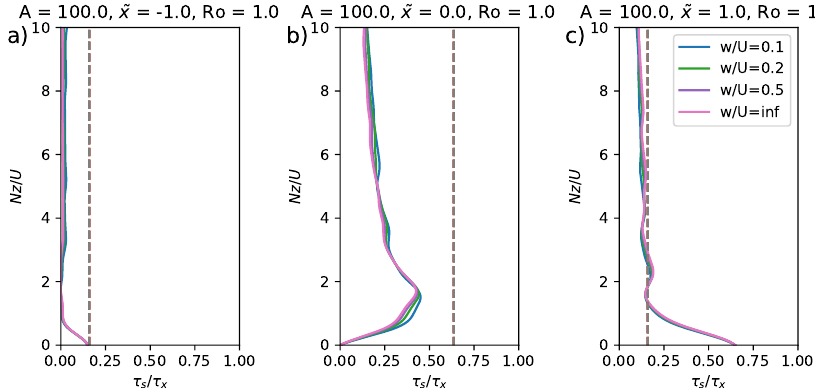
Figure 5. As in Figure 3, but for the case with A = 100, Ro = 1. Results are plotted at ( a ) ˜ x = − 1, ( b ) ˜ x = 0, and ( c ) ˜ x = 1. The dotted vertical line shows the asymptotic correction factor 2/ ( π ( 1 + ˜ x 2 ) 2 ) for a vertical profile in the case without Coriolis